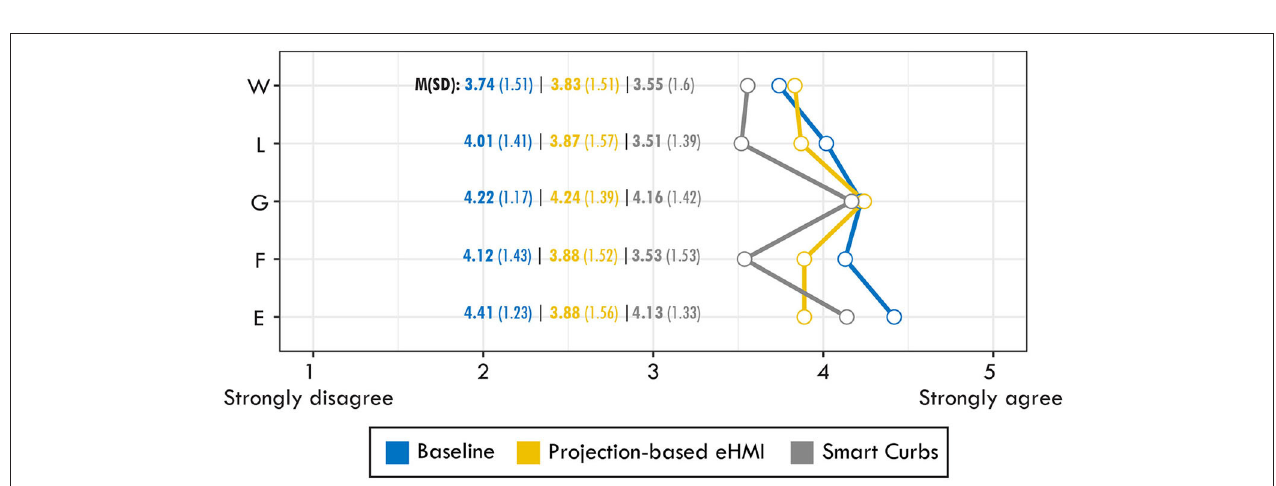
FIGURE 7 | Results of the QUESI questionnaire measuring subjective consequences of intuitive use. A line graph showing the results of the QUESI questionnaire. It includes the following data graphically